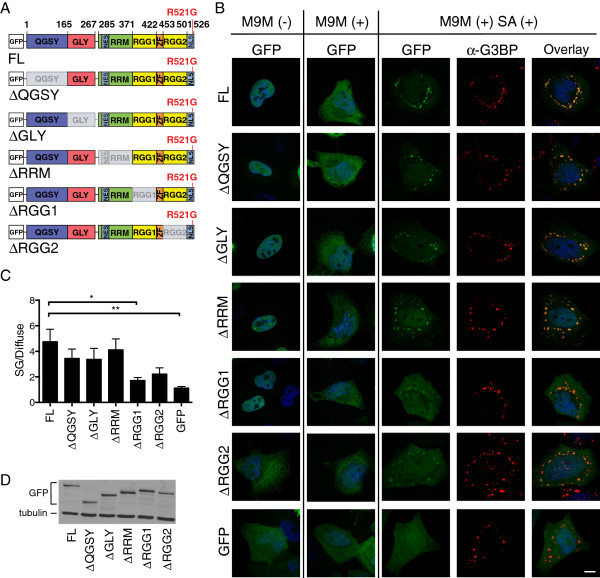
The RGG domains modulate the incorporation of FUS into arsenite-induced stress granules. (A) Illustration of full length (FL) GFP-FUS R521G and constructs lacking the following sequences: Gln-Gly-Ser-Tyr-rich (∆QGSY), Gly-rich (∆GLY), RNA recognition motif (∆RRM), and Arg-Gly-Gly-rich (RGG) regions (∆RGG1 and ∆RGG2). (B) Confocal images of HeLa cells transfected with GFP-FUS R521G constructs (green) alone (−) or co-transfected (+) with MBP-M9M, the transportin-1 inhibitor. Note the increased levels of cytoplasmic GFP-FUS in co-transfected cells (compare columns 1 and 2). Confocal fluorescence images of co-transfected cells treated with 0.5 mM sodium arsenite for 1 hr were used to assess the ability of GFP-FUS R521G constructs (green; column 3) to associate with stress granules (G3BP; red; column 4). The greatest degree of GFP and G3BP co-localization was observed in cells expressing FL GFP-FUS R521G, whereas there was minimal co-localization in control cells expressing free GFP (compare panels in column 5). (C) Quantitative analysis (see Materials and methods) of (B) reveals that constructs lacking RGG domains (∆RGG1 and ∆RGG2) exhibit impaired localization to stress granules. Statistically significant comparisons include FL and ∆RGG1 (*P < 0.05), FL and GFP (**P < 0.01), and ∆QGSY and GFP (*P < 0.05; not shown on graph for clarity) by one-way ANOVA followed by a Dunnett’s post-hoc test on n=3 independent experiments. All error bars represent SEMs. (D) Western blot analysis of HeLa cells in (B) demonstrates equivalent expression levels for all GFP-FUS R521G constructs.